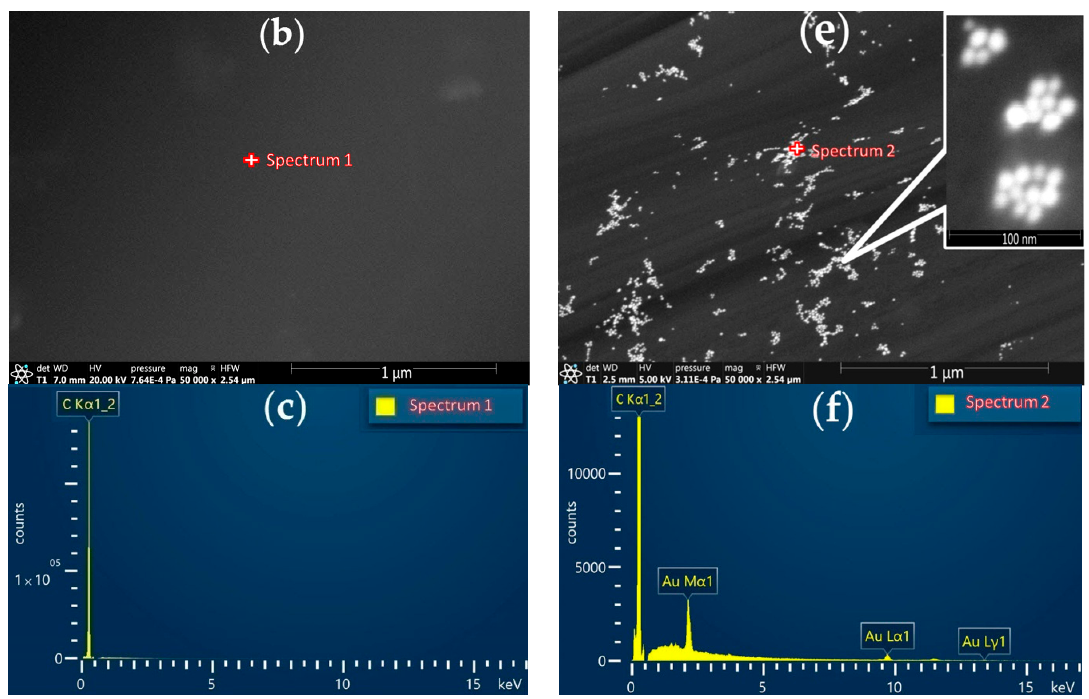
Figure 3. SEM-images of bare CVE ( a, b ) and Au-gr/CVE ( d, e ) and EDS spectrum of CVE ( c ) and Au-gr/CVE ( f ).